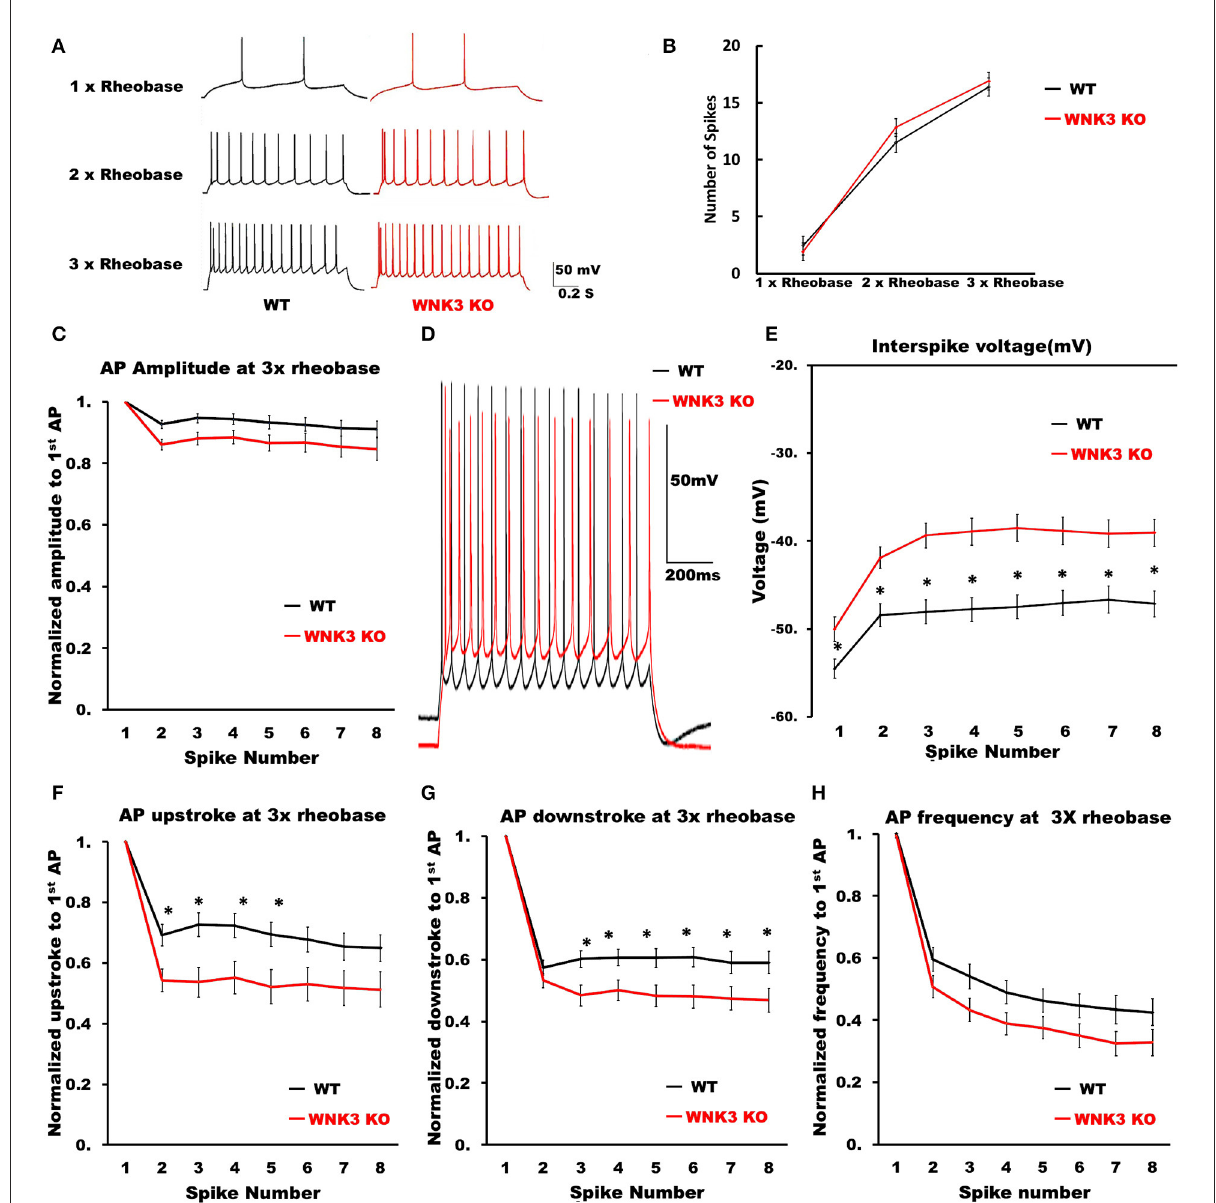
FIGURE7 Repetitive firing frequencies are not affected in WNK3 KO neurons at multiples of rheobase currents. (A) Representative traces for repetitive firing at 1X, 2X, and 3X rheobase currents. WT (black) and WNK3 KO (red). The current injection duration is 1,000ms. Scale bar as in figure inset (50mV, 200ms). (B) Plot of the relationship between the number of spikes and current injection at 1X, 2X, and 3X rheobase currents; WT (black) and WNK3 KO (red). (C) Normalized to first AP amplitude for first eight spikes at 3X rheobase. (D) Representative repetitive firing traces for 1,000ms current injection at 3X rheobase currents for layer V pyramidal neurons (WT, black and WNK3 KO, red). Note the persistent depolarized interspike voltage in WNK3 KO neuron. Scale bar as in figure inset (50mV, 200ms). (E) Quantitative analysis of interspike voltage at 3 X rheobase ( t- test , * P < 0.05). (F) Normalized AP upstroke for the first eight spikes at 3X rheobase indicates a significant reduction in upstroke during repetitive firing ( t- test , * P < 0.05). (G) Normalized AP downstroke at 3X rheobase is significantly slower ( t- test , * P < 0.05). (H) However, normalized instantaneous frequencies at 3X rheobase are not